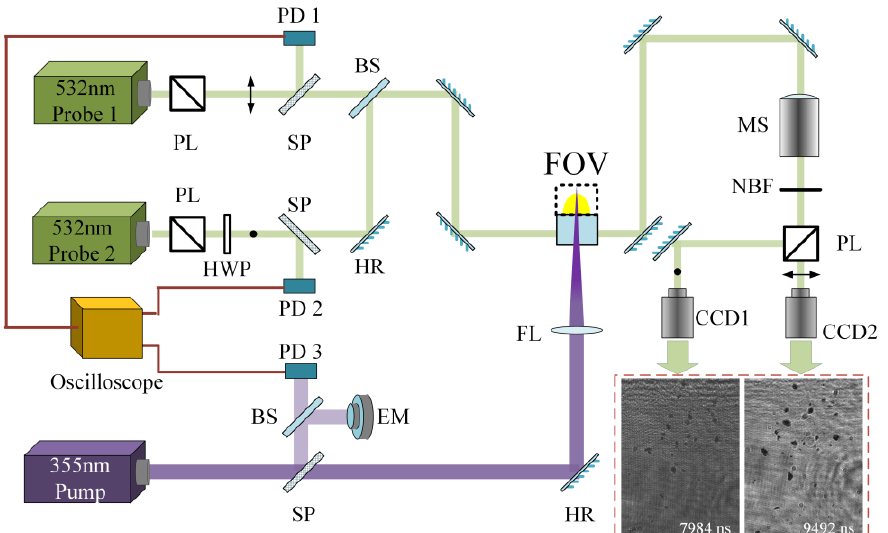
Figure 1. Schematic of time-resolved imaging for capturing transient particles after a laser-induced breakdown event. PD: photon detector, PL: polarized lens, SP: sampler, HWP: half-wave plate, BS: beam splitter, FL: focus lens, NBF: narrowband filter, MS: microscope, HR: high reflector, EM: energy meter, FOV: field of view.